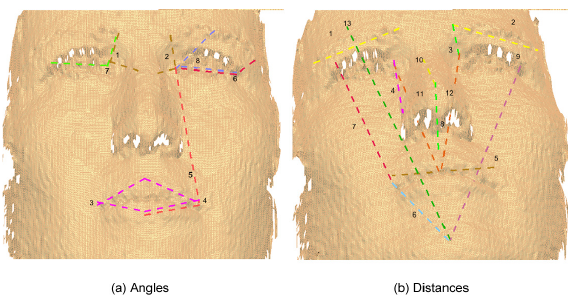
Figure 10. Original 2D features.